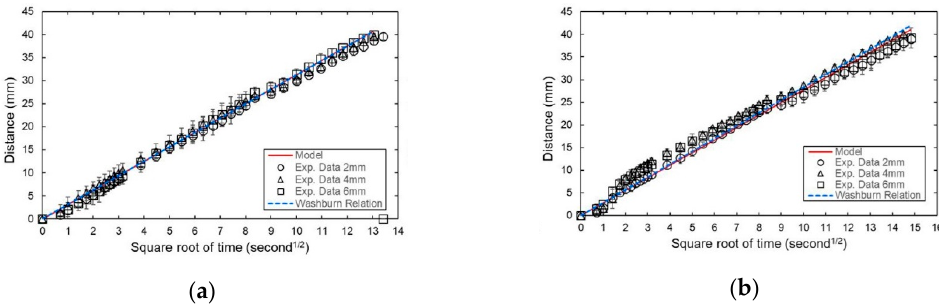
Table 6. Fitting coefficient p of Washburn relation of NC paper.